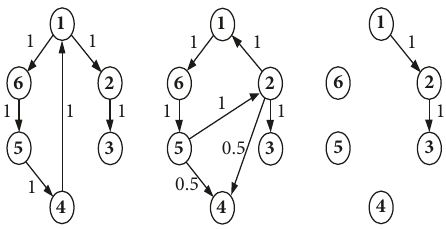
Figure 1: Graph G 1 , G 2 , and G 3 in sequence.